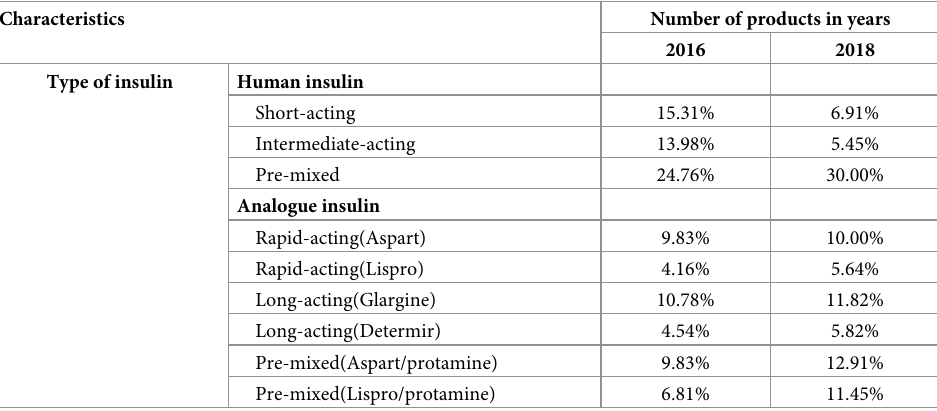
Table 4. Types of insulin products found in the pharmacies.